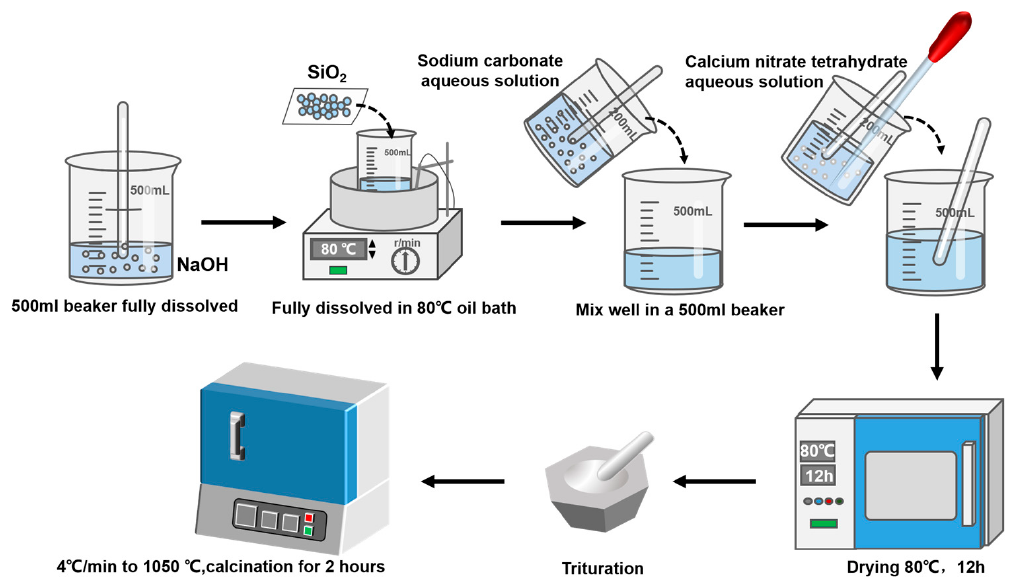
Figure 7. The NCSO catalyst preparation scheme.